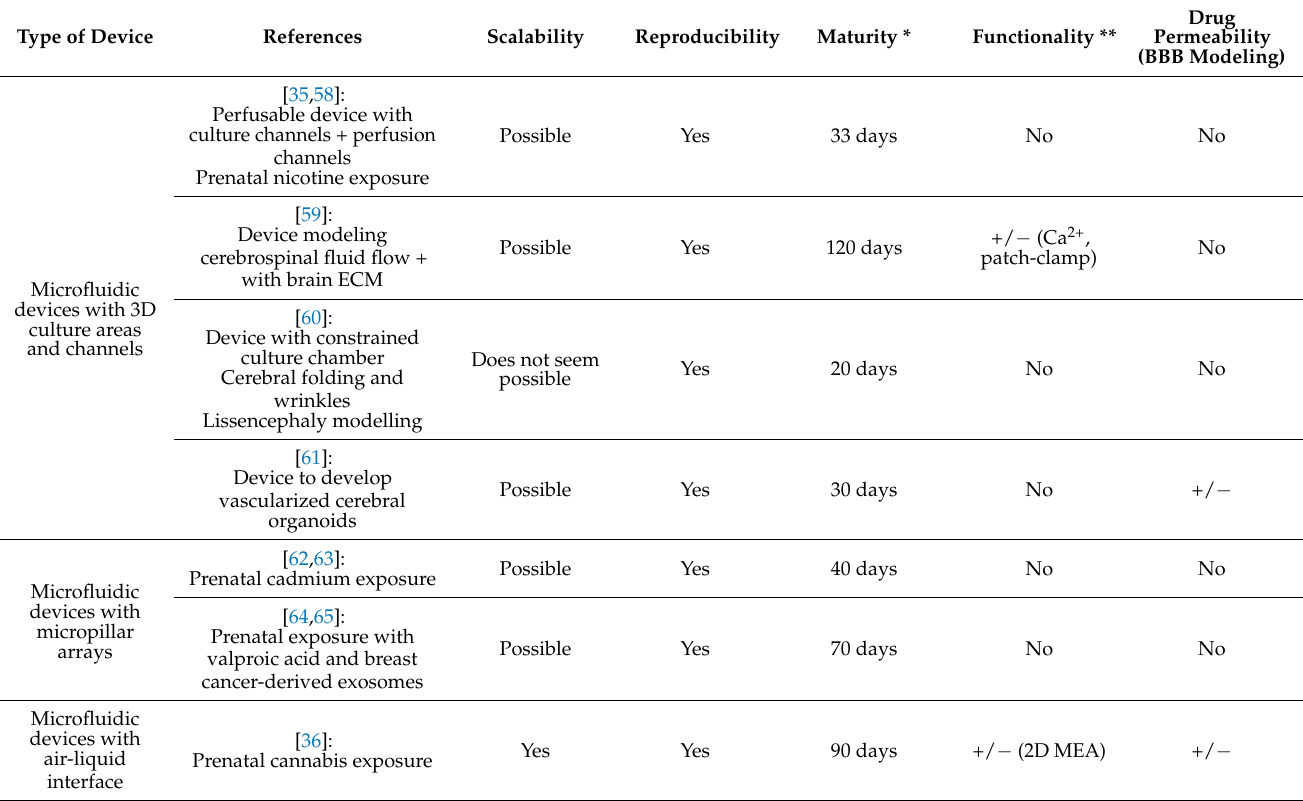
Table 2. Advantages and current limitations of brain organoids-on-chip technologies regarding pharmaceutical